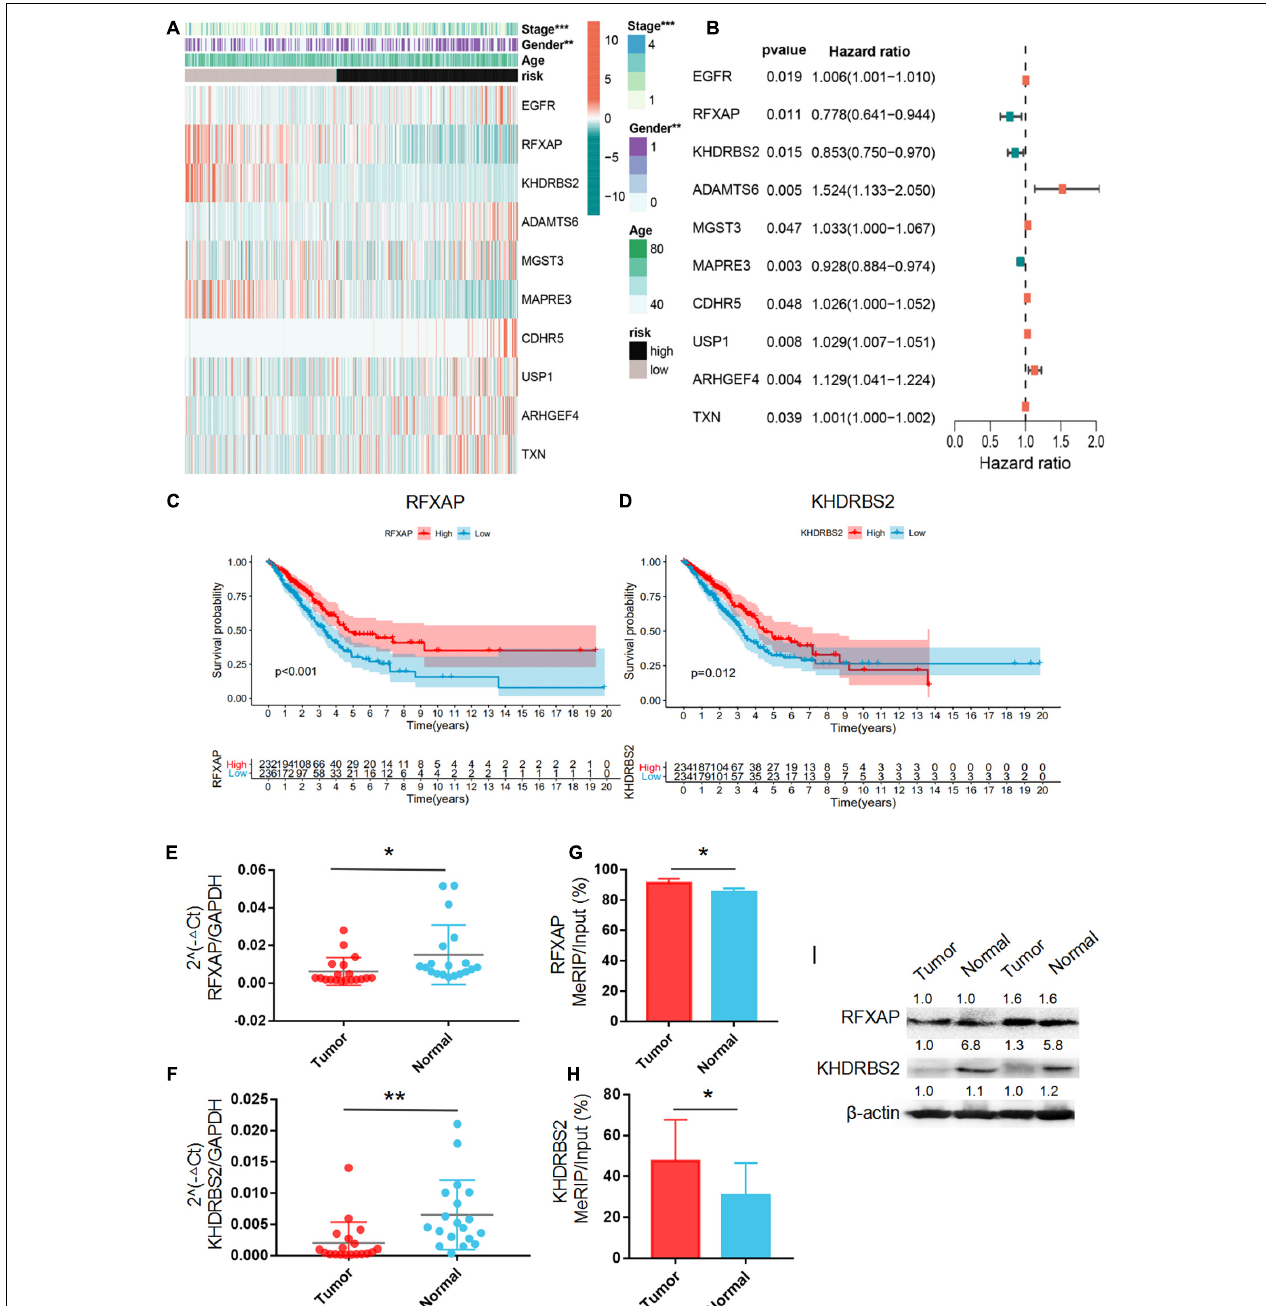
FIGURE 7 | Principal Component Analysis. (A) Forest plot of the prognostic ability of the 10 m6A-regulated mRNAs included in the prognostic signature. (B) Heatmap of the 10 m6A-regulated mRNA expression levels with different clinicopathological features. (C,D) Overall survival curves according to RFXAP and KHDRBS2 mRNA expression in TCGA LUAD patient cohorts. The mRNA expression level (E,F), m6A methylation level (G,H) and protein expression level (I) of RFXAP and KHDRBS2 in LUAD in LUAD tissues (Tumor) and adjacent non-tumor tissues (Normal). * P < 0.05, ** P < 0.01, and *** P <